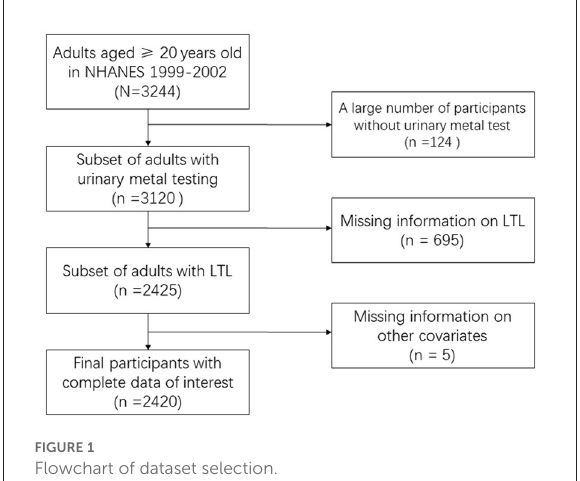
FIGURE1 Flowchart of dataset